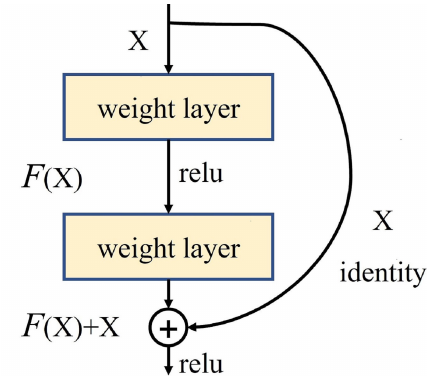
Figure 5. Residual block from the ResNet